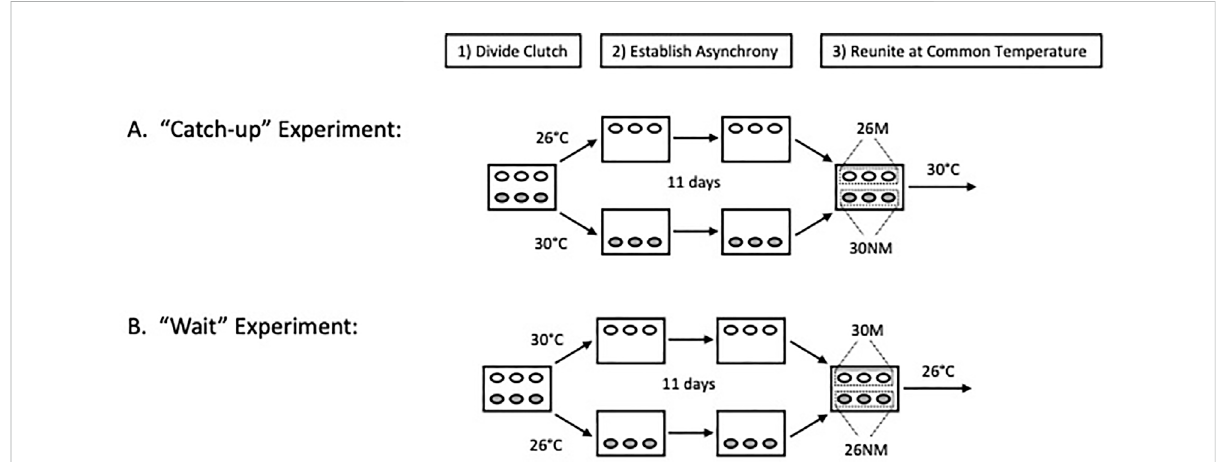
FIGURE 1 General incubation protocol (modi fi ed from Figure 2 of Colbert et al., 2010). The steps employed to establish developmental asynchrony and promoteshortenedincubationperiodsoflessadvancedembryos.Temperaturesused(26or30 ° C)dependedonthetreatmentand11 daysindicates the period over which asynchrony was established in the study.